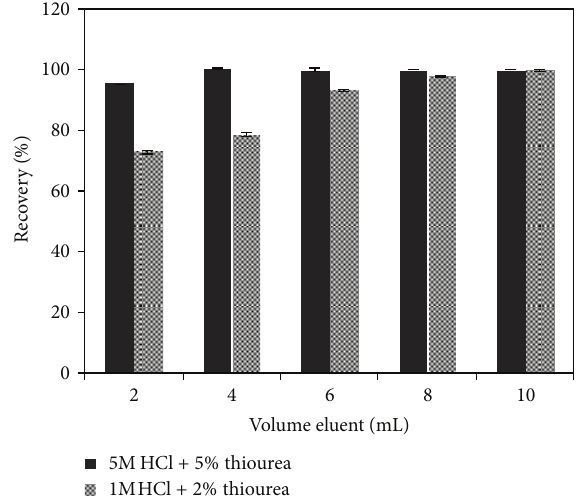
Figure7:EffectofeluentvolumeontherecoveryofHg(II)adsorbed on 5Ph8HQ by column method. Conditions: [Hg 2+ ]: 2 ng mL −1 , 𝑉 (50mL), pH 4, and eluent: 5 M HCl + 5% CS (NH 2 ) 2 /1M HCl + 2% CS (NH 2 ) 2 . Bars represent standard deviation for two